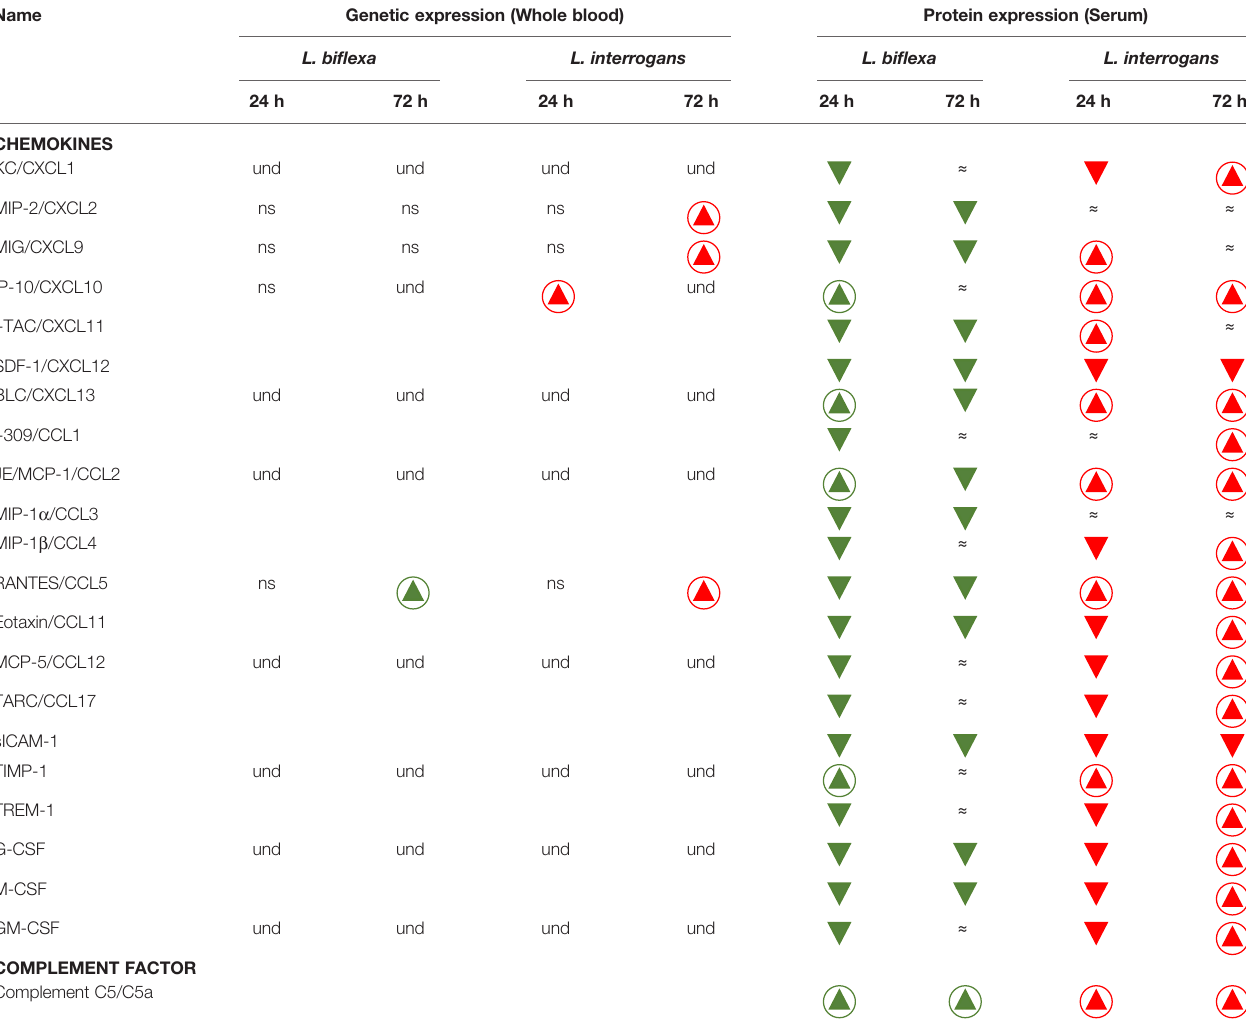
TABLE 1 | Chemokines and complement factor affected during early infection with pathogenic and non-pathogenic Leptospira in comparison with control.